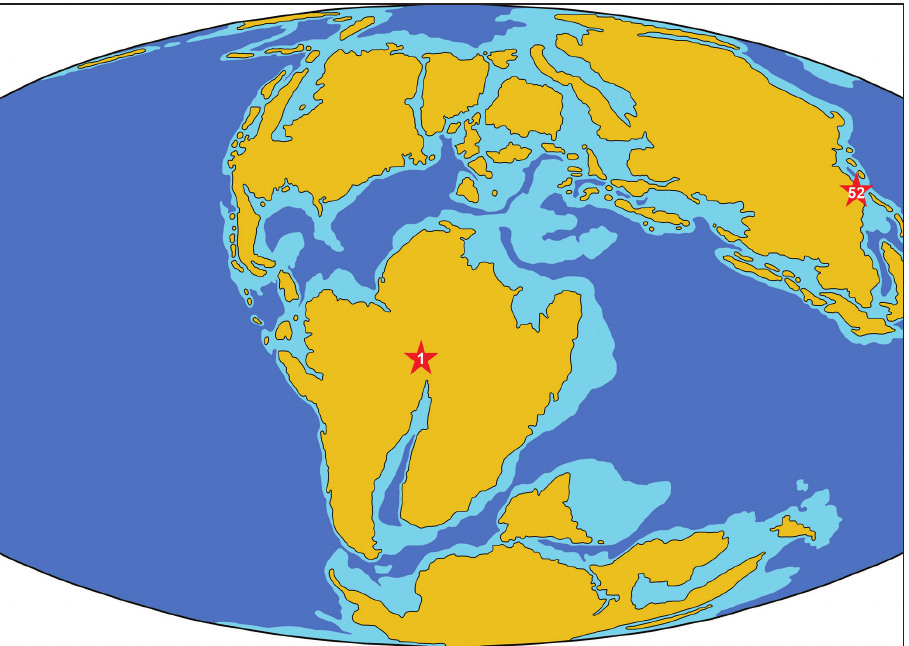
Figure 2. Paleogeographic map of the Early Cretaceous (120 Ma) showing Aptian-age localities of azh- darchids. The numbers of localities correspond to the list in the text. The map is modified from http://jan.